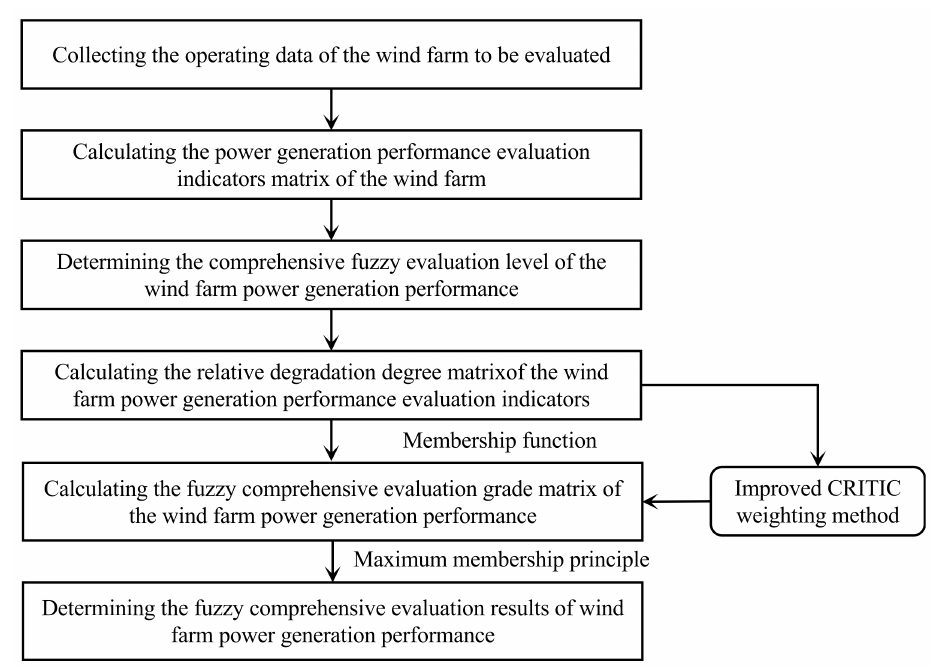
Figure 2. Modeling process of wind farm power generation performance comprehensive evalua- tion